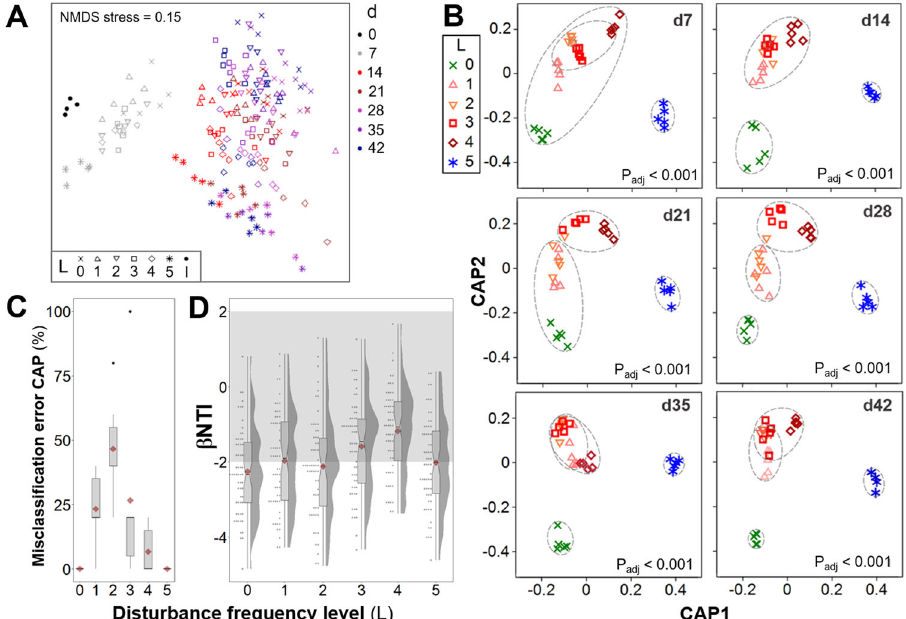
Fig. 2 Temporal dynamics of β -diversity community structure and assembly for bacterial ASV data across different frequencies of organic loading disturbance ( n = 5 bioreactors). A Unconstrained NMDS ordination (weighed Unifrac β -diversity, Hellinger transformed data) for all 184 samples collected. Disturbance frequency levels (L): 0 (undisturbed), 1 – 4 (intermediately disturbed), 5 (press disturbed). I: Sludge inoculum (day 0, n = 4). B Constrained canonical analysis of principal coordinates (CAP) ordinations (Bray – Curtis β -diversity, squared root transformed data) on different sampling days, including ellipses of 60% group-average cluster similarity and PERMANOVA adjusted P -values. C Misclassi fi cation errors at each disturbance frequency level, via the leave-one-out allocation of observations to groups from CAP at each time point after d0 ( n = 6 sampling days). Bray – Curtis β -diversity, squared root transformed data. Red diamonds display mean values. The box bounds the IQR divided by the median, and Tukey-style whiskers extend to a maximum of 1.5 times the IQR beyond the box. D Beta nearest taxon index ( β NTI) at each disturbance frequency level, from pairwise comparisons across within-treatment replicates at each time point after d0 ( n = 60 comparisons). Red diamonds display mean values. Notches show the 95% con fi dence interval for the median. When notches do not overlap, the medians can be judged to differ signi fi cantly. Shaded in gray is the zone where stochastic processes signi fi cantly dominate, | β NTI| < 2. β NTI values closer to zero indicate a higher relative contribution of stochastic